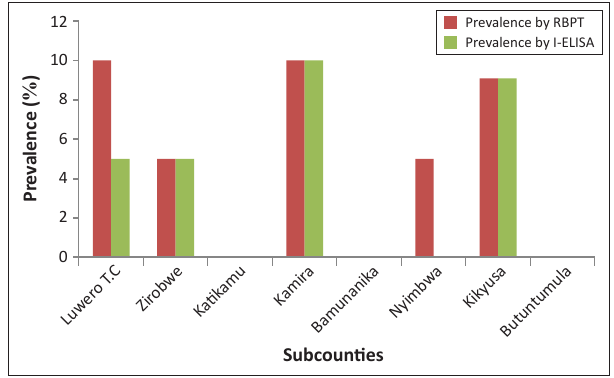
FIGURE 2: Prevalence of antibodies against Brucella abortus by sub-counties in the Luwero